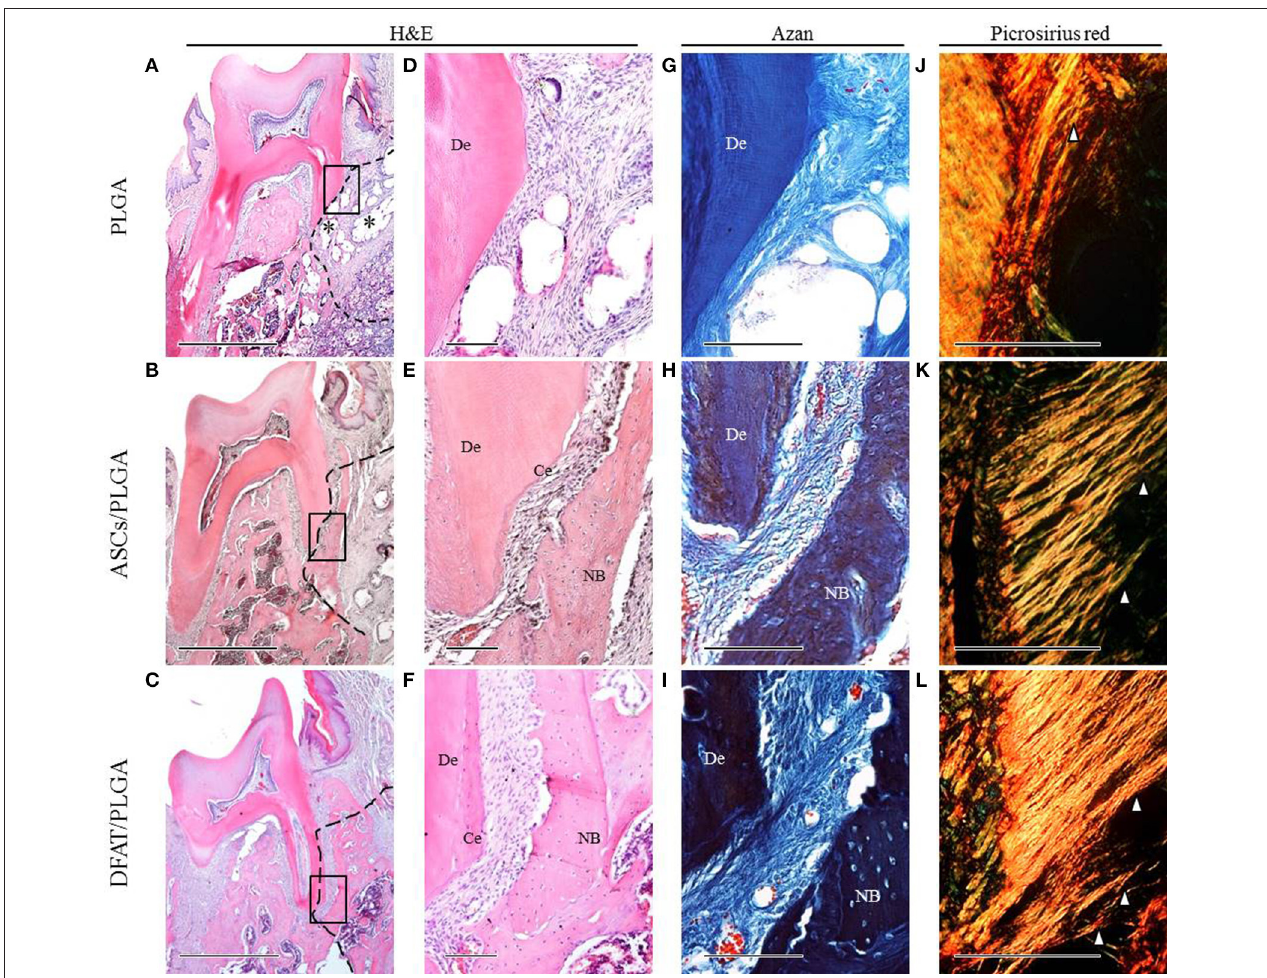
FIGURE 7 | Representative histological observation of frontal plane section in central root of first molar. (A–C) Overview of H&E staining. No alveolar bone formation was observed in the PLGA-alone group. Asterisk indicate scaffold remnant. Alveolar bone formation was observed in the ASCs/PLGA and DFAT/PLGA groups. The dotted line indicates defect site. Scale bar = 1000 µ m. (D–F) Higher magnification of the framed areas in (A–C) , respectively. No cementum formation was observed in the PLGA-alone group and newly formed cementum was observed in the ASCs/PLGA and DFAT/PLGA groups. Scale bar = 100 µ m. (G–I) Higher magnification of the framed area in (A–C) , respectively, with Azan staining to observe the periodontal ligament fibers. Scale bar = 100 µ m. (J–L) Enlarged images of the area equivalent to (G–I) , stained with Picrosirius-red to show Sharpey’s fibers. Arrowheads indicate newly formed collagen fibers. Scale bar = 100 µ m. NB, newly formed bone; Ce, newly formed cementum; De, root